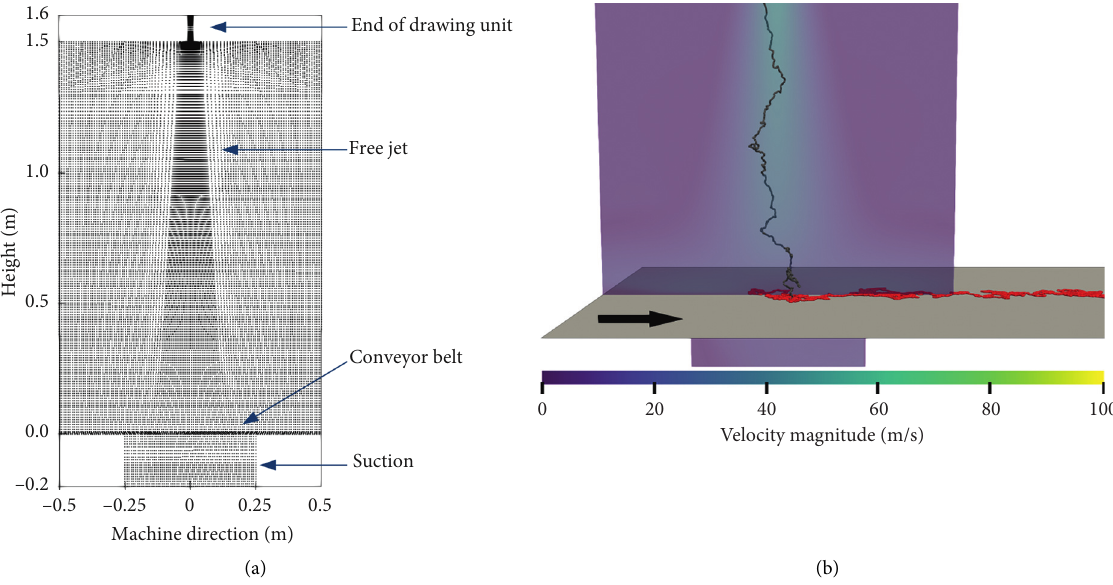
Figure 2: (a) Mesh of the used simulation domain for the air stream; the domain covers mainly the free jet in spunbond processes from the end of the drawing unit to the conveyor belt with suction underneath. (b) Exemplary result of a fiber dynamics simulation; the fiber parts in the air are colored black, the deposited fiber parts on the conveyor belt red. The air stream is visualized as a